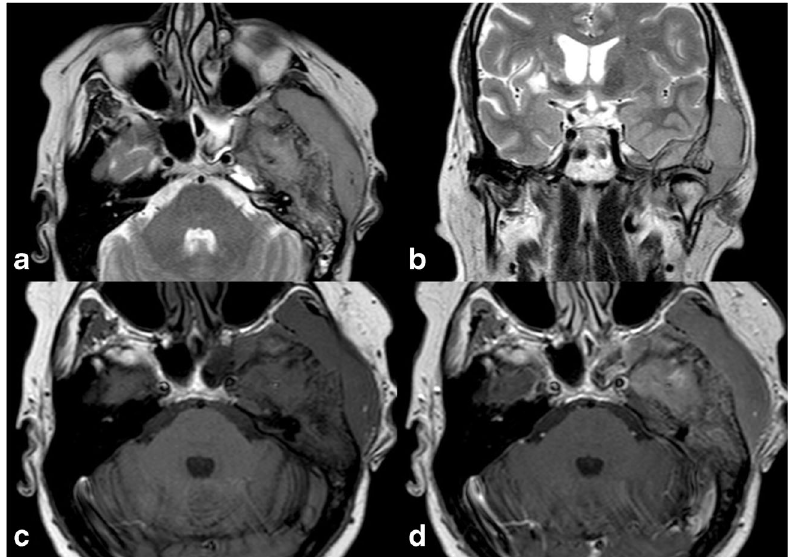
Fig. 12 Primary lymphoma of the bone, same patient shown in Fig. 11. On MRI, the lesion demonstrates low T2 signal on axial ( a ) and coronal ( b ) T2- weighted sequences and exten- sion to the temporal fossa and to the epidural space of the middle cranial fossa. The tumour exhibits homogeneous contrast enhance- ment; axial T1-weighted before ( c ) and after ( d ) contrast administration